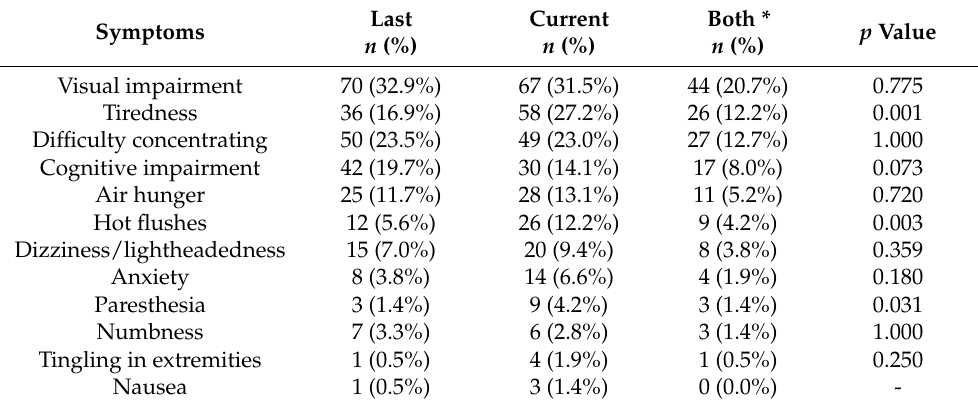
Table 2. Comparison of hypoxia symptoms between the last and current altitude hypoxia